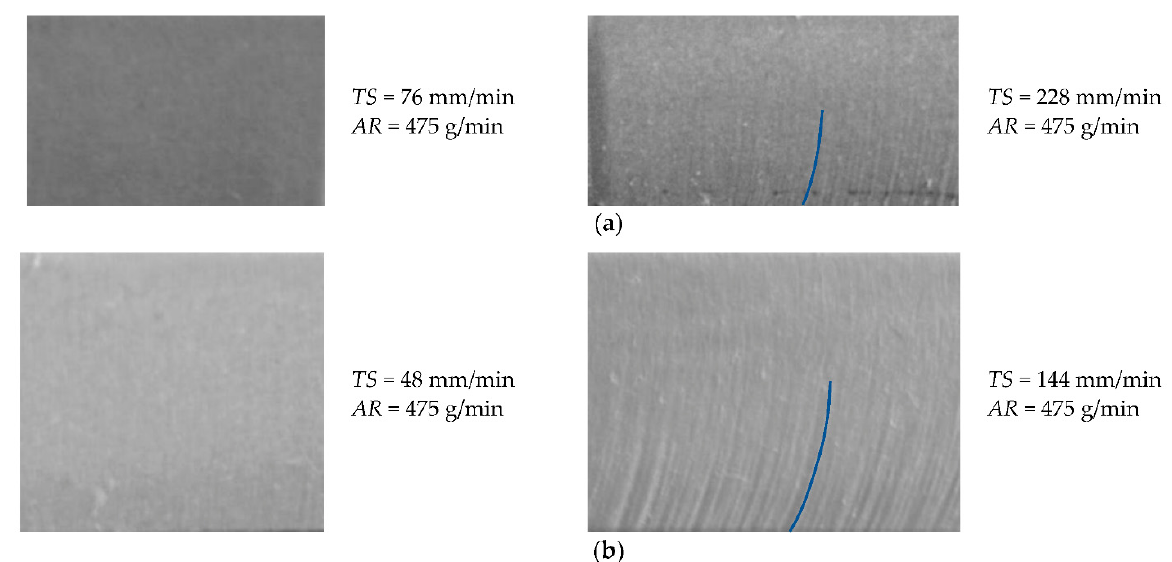
Figure 3. The images of cut surface: ( a ) for the material thickness of 10 mm and ( b ) for the material thickness of 15 mm.